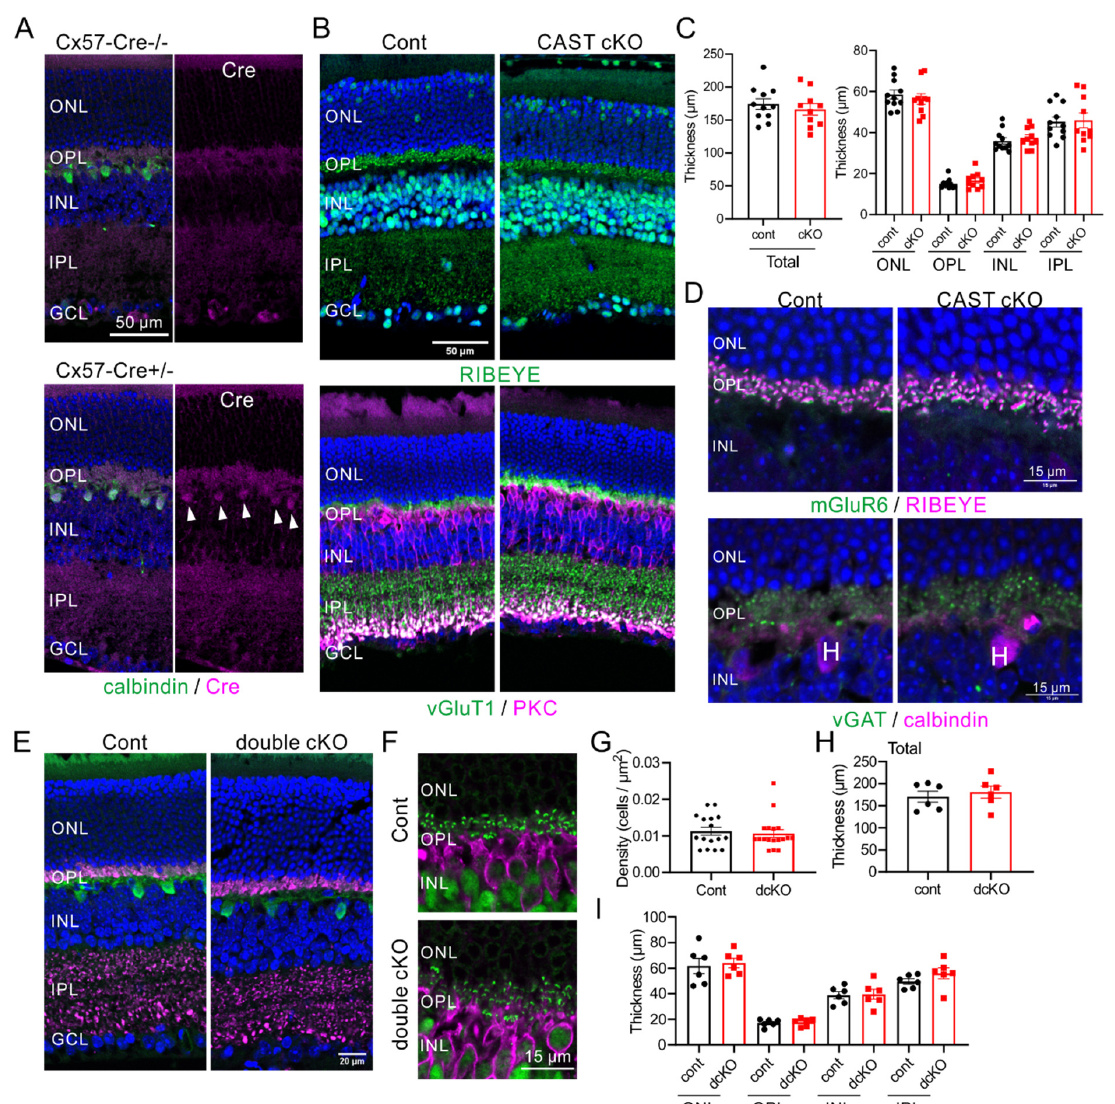
Figure 3. Depletion of CAST and ELKS from horizontal cells does not affect neural or synaptic distribution ( A ) In the Cx57-Cre mice, co-labeling for Cre was detected in calbindin-labeled horizontal cells in the upper part of the INL (white arrows). ( B , C ) Representative images of immunolabeled retinal sections showing the distribution of photoreceptor ribbon synapses (anti-RIBEYE), terminals (anti-vGluT1) in the OPL, and postsynaptic bipolar cells (anti-PKC) in the CAST-flox;Cx57-Cre +/ − (cKO) mice. The total thickness and thickness of each layer were not significantly different between control and cKO; mean ± SEM (Student’s t -test). ( D ) Immunohistochemistry showing the parallel distribution of presynaptic ribbon synapses and postsynaptic mGluR6 in the OPL. The inhibitory synapses (labeled by anti-vGAT antibody) were distributed at calbindin-labeled horizontal cell dendrites, which were unaffected in CAST cKO mice. ( E – I ) In the CAST-flox and ELKS-flox;Cx57- Cre +/ − (double cKO) mice, the horizontal cells (calbindin-positive) were localized at the upper part of the INL, and the photoreceptor terminals (anti-vGluT1) and ribbon synapses (anti-RIBEYE) were distributed in the OPL. The horizontal cell density and layer formation in the double cKO mice were not significantly different from the control; mean ± SEM (Student’s t